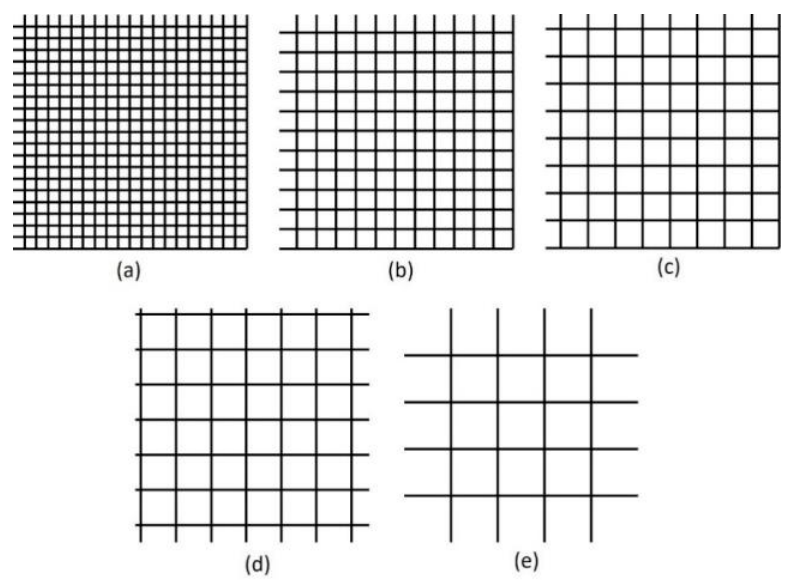
Figure 3. Mesh patterns with pitch of ( a ) 30, ( b ) 50, ( c ) 70, ( d ) 90, and ( e ) 110 μ m.